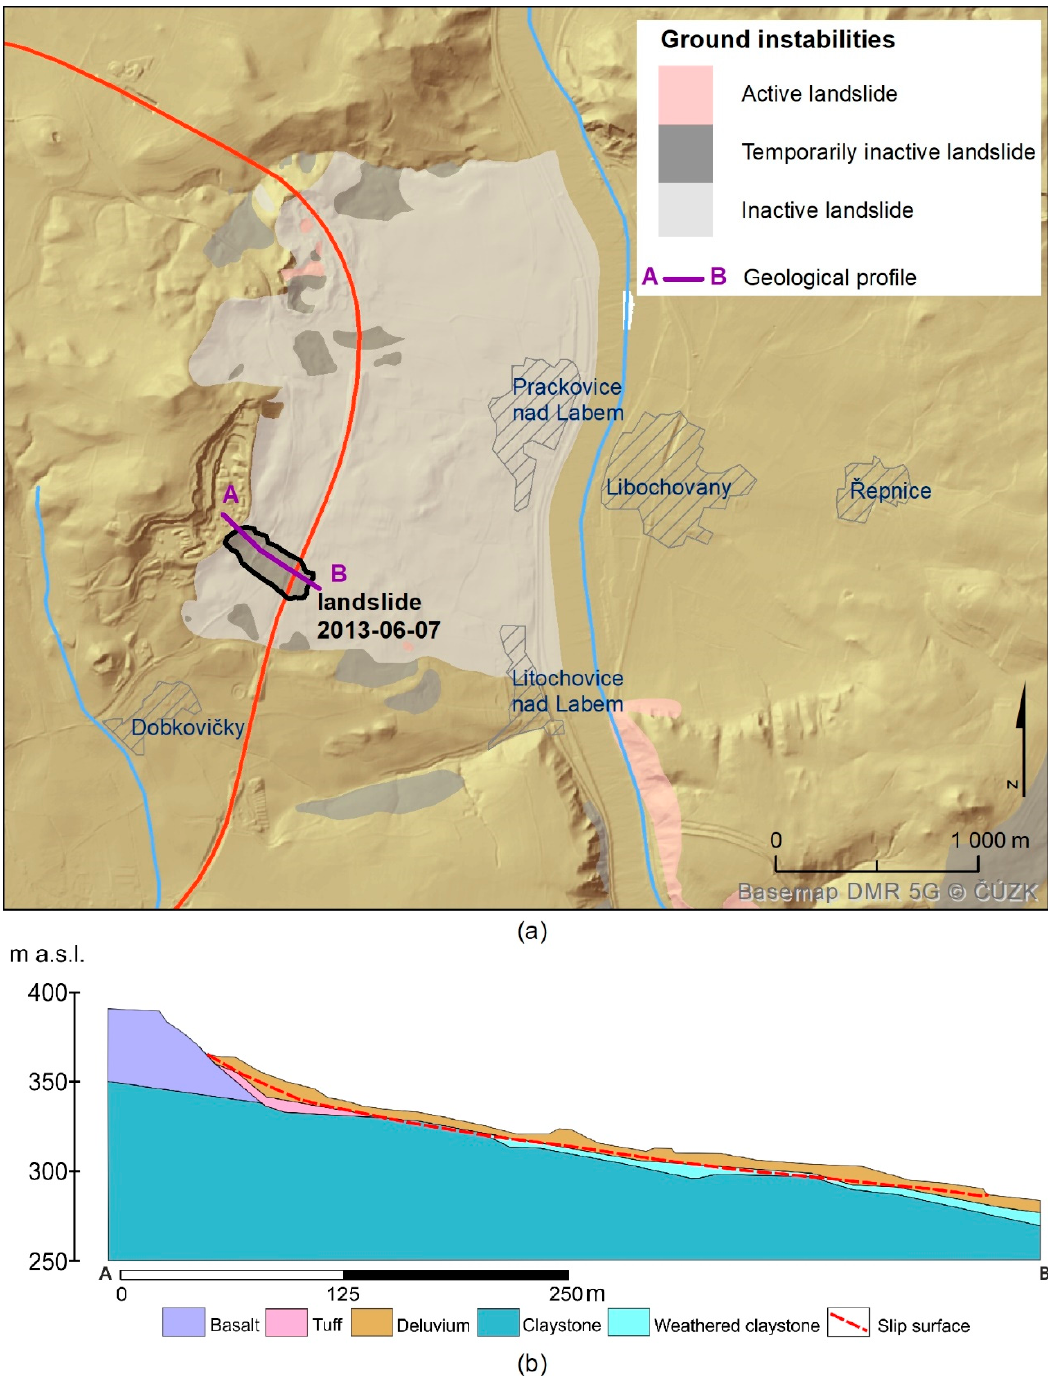
Figure 2. ( a ) Ground instabilities in the area of interest [46], and ( b ) geological profile, adapted by